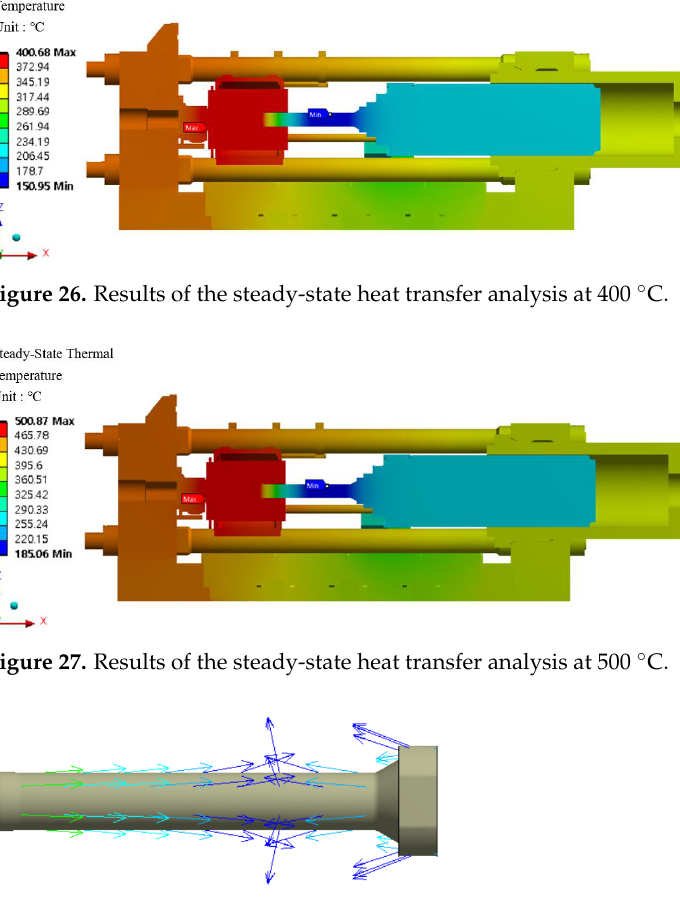
Figure 25. Heat transfer analysis process in ANSYS Mechanical.